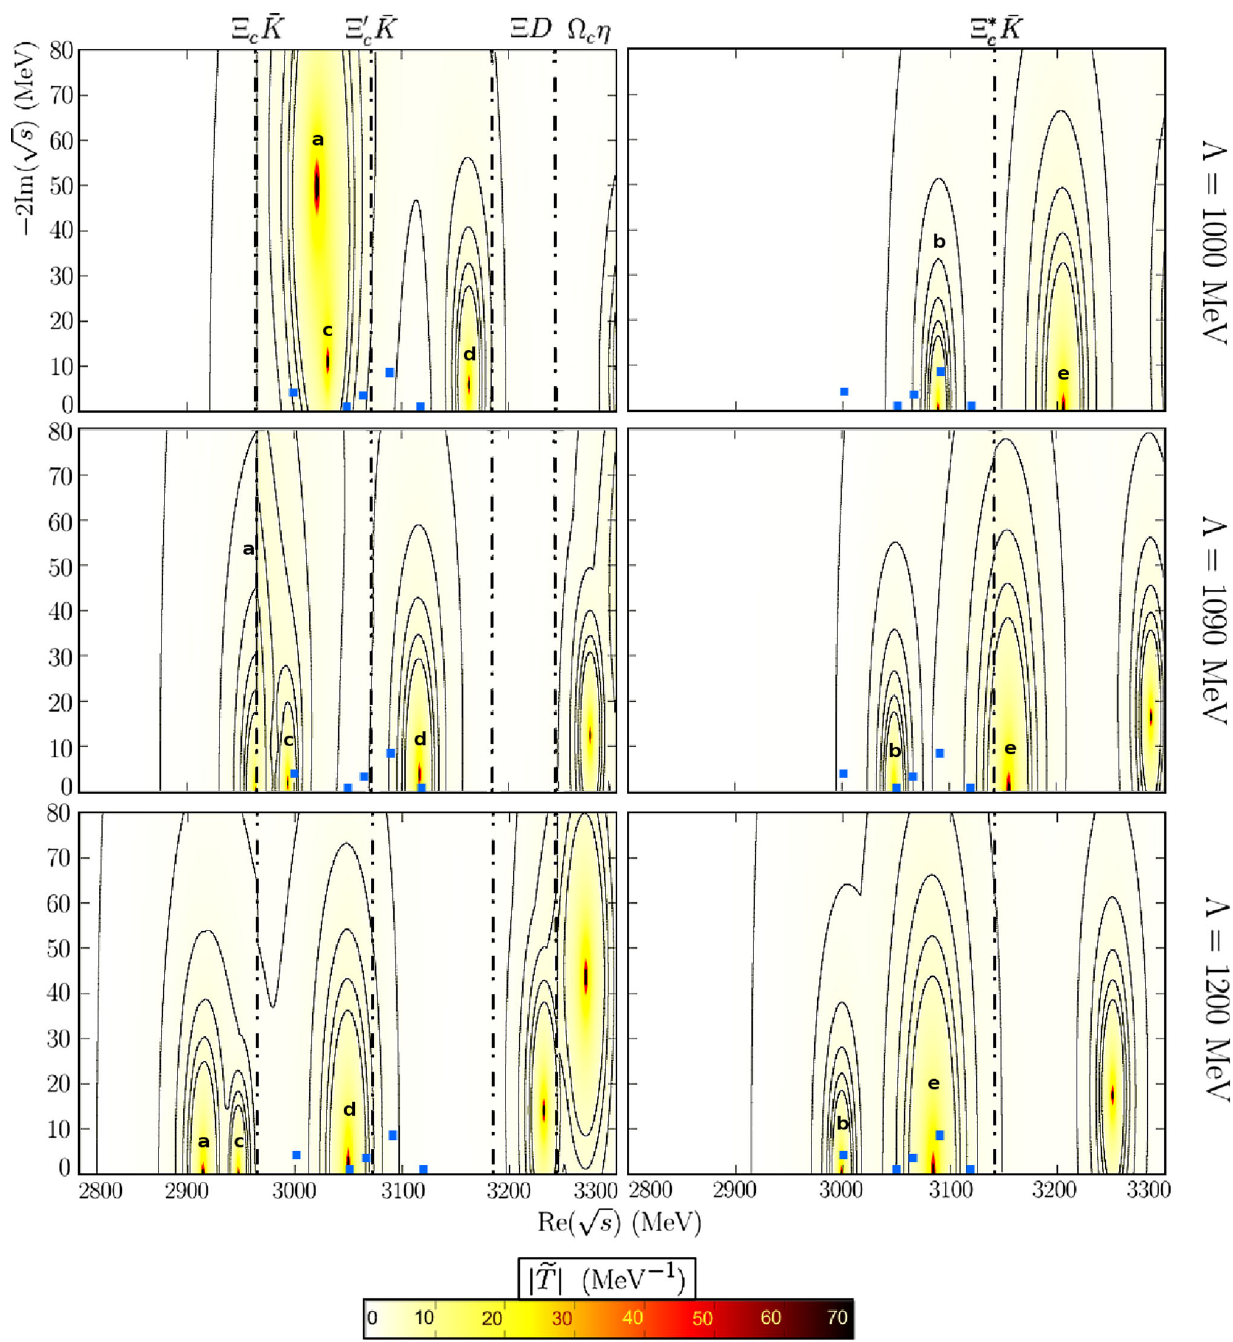
Fig. 3 (cid:2) c and (cid:2) ∗ c statesfordifferentUVcutoffs.Thebluesquaresindi- For the two largest values of (cid:3) , some resonant states from less attrac- cate the experimental points. Dashed-dotted lines represent the closest tive SU ( 6 ) lsf × HQSS multiplets, stemming from the exotic 4752 SU(8) baryon-meson thresholds. The left plots are for J = 1 representation, are also visible in the region of higher and the right 2 ones for J = 3 , while the function | ˜ T ( z ) | J is defined as in Fig. 1. 2